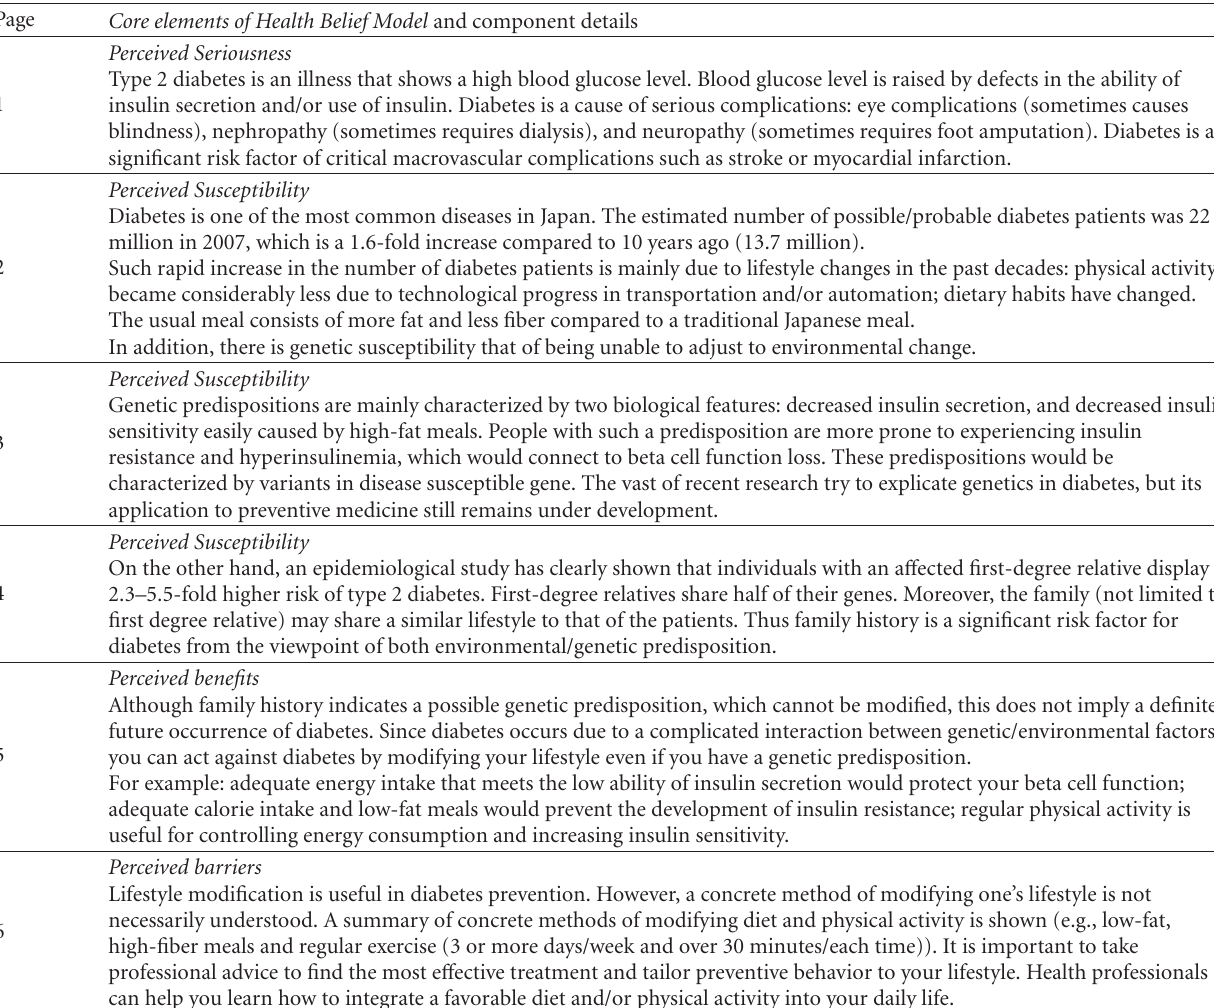
Table 5: Details of a booklet about diabetes prevention for people with a family history of